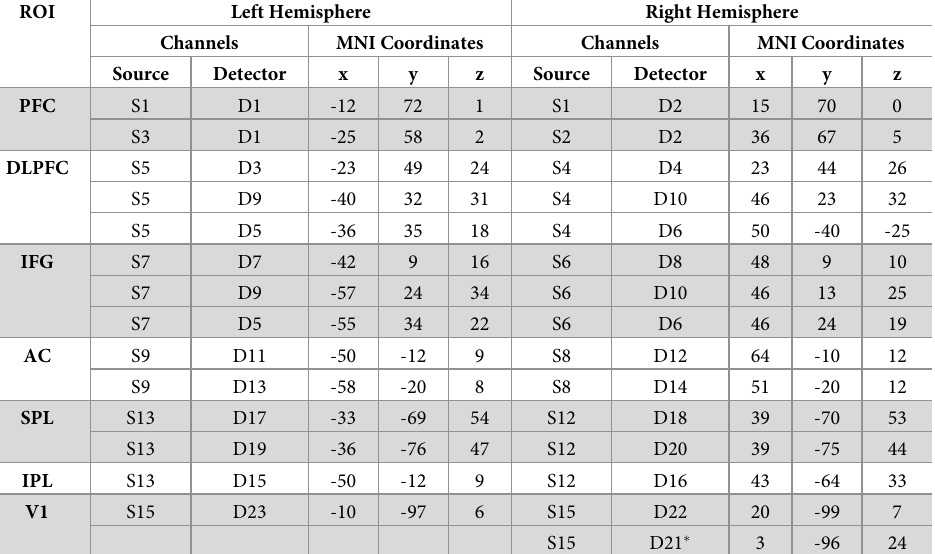
Table 1. Description of fNIRS ROIs and measurement channels. ROI Left Hemisphere